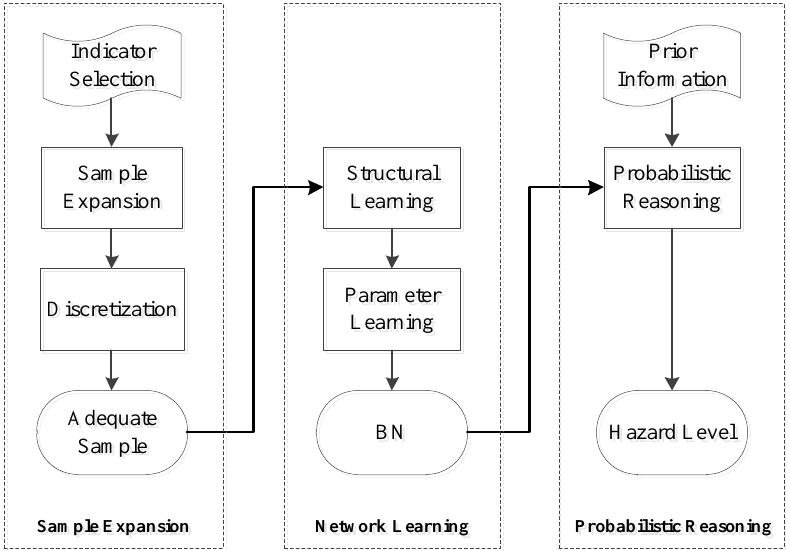
Figure 1. Technical process based on information diffusion and BN.